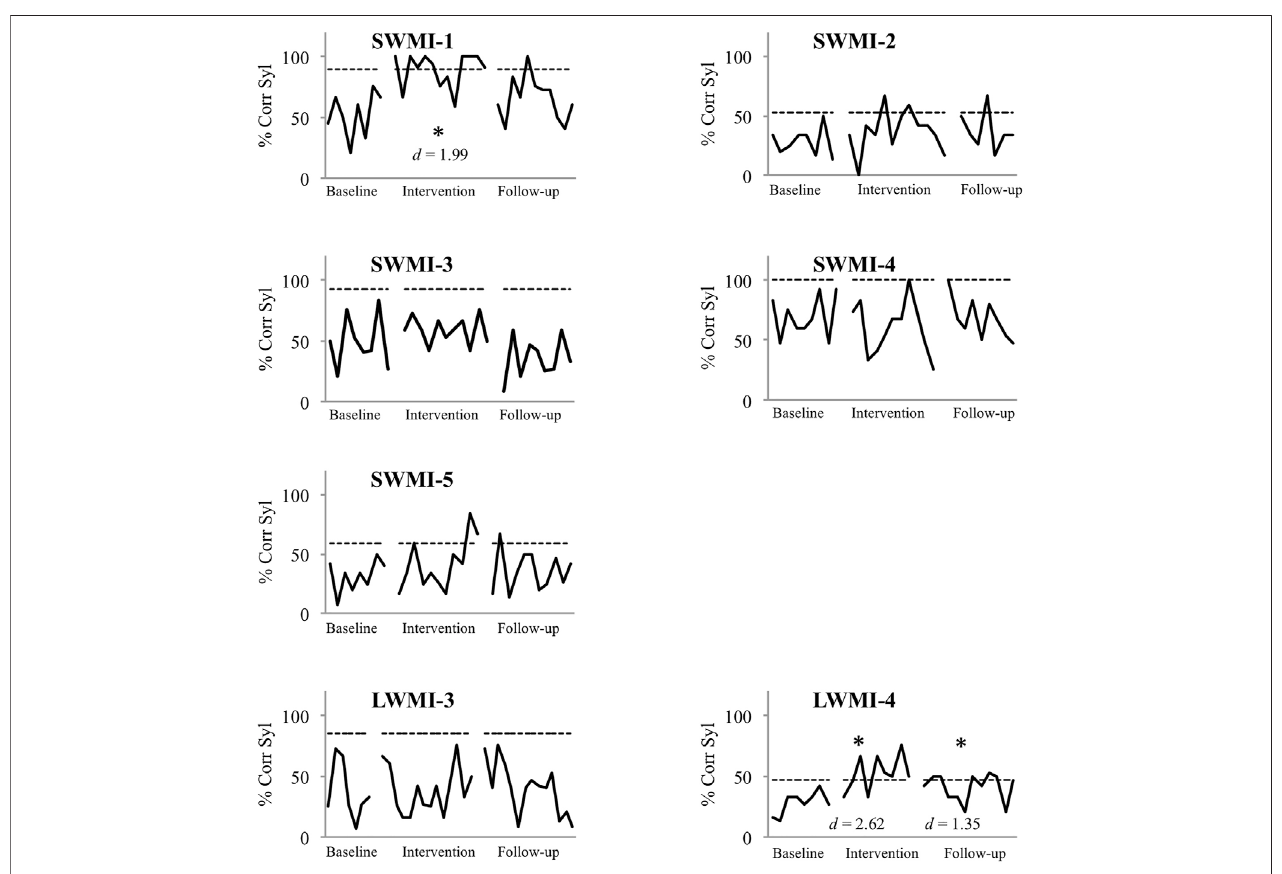
FIGURE 4 | Nonword repetition probe. Dashed line represents 2 SD above mean baseline score. Asterisks indicate signi fi cant improvement from baseline using 2 SD limit. All unmarked effect sizes d < 0.8.